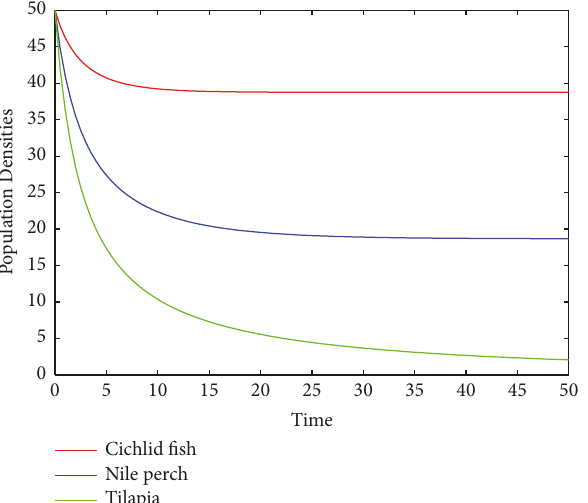
Figure 1: Graph of prey 𝑥 1 and 𝑥 2 and predator 𝑥 3 against time (in years). It shows the variation of population density with time.